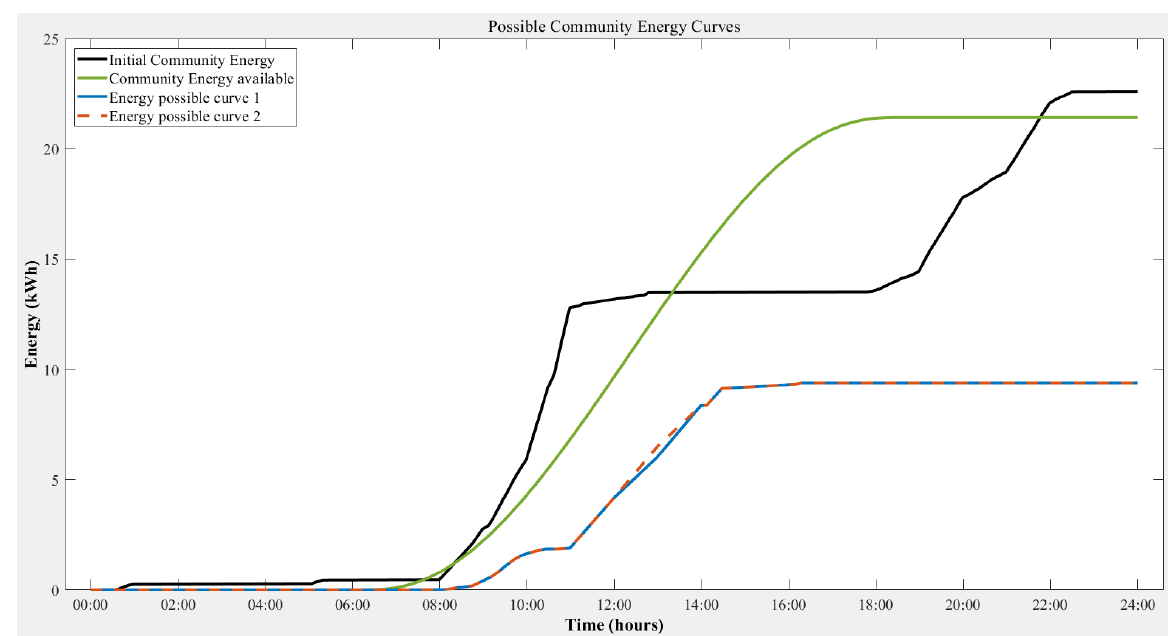
Figure 15. Community’s energy profile in Scenario 1.